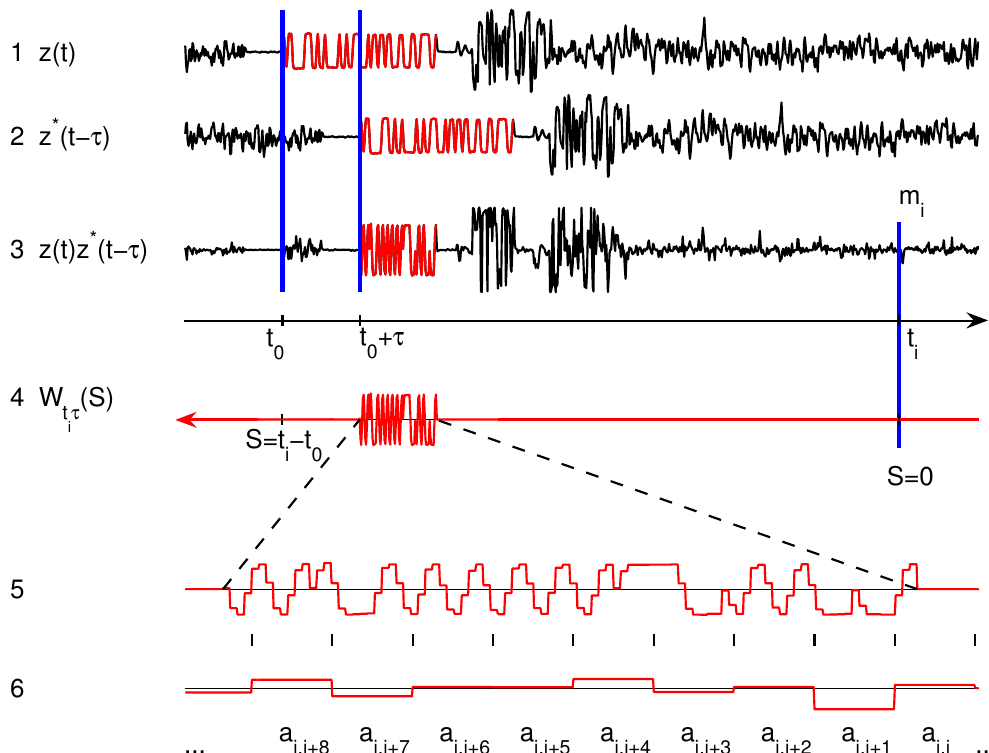
Fig. 2. Producing the linear coefficients for lag profile inversion: On line 1 is a short time sequence of the received signal containing one transmission (marked with red color). On line 2 is the complex conjugate of the signal shifted by the lag-increment τ . By multiplying 1 and 2 both the lag profile and range ambiguity function (the red part of the curve) are produced. The range ambiguity function is in a coordinate system with positive S-axis to left in the figure and the origin (S=0) at the point t = t i ( t i is the instant of time when the ambiguous lagged product m i was measured). On line 5 is a blow-up of the non-zero part of the range ambiguity function. The limits of range-gates are marked with black vertical bars between lines 5 and 6. All points of the range ambiguity function that lie inside the same gate are summed together to produce the linear coefficients a i,k on line 6.